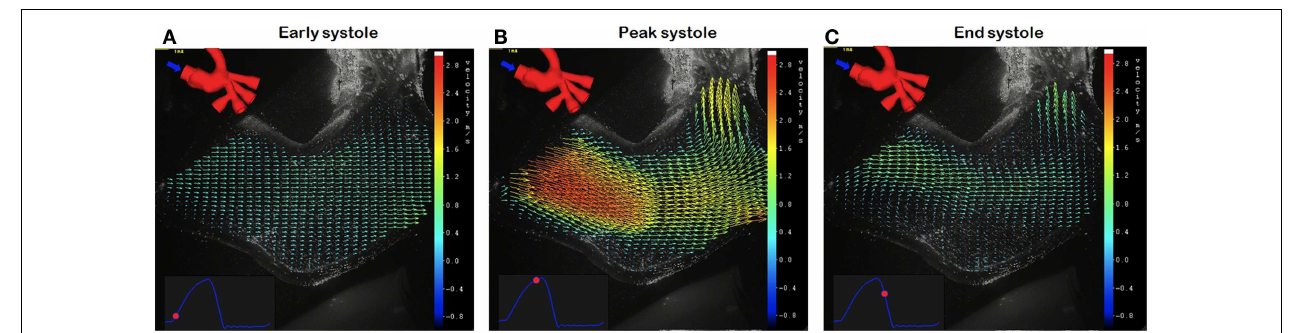
FIGURE 2 | Experimental set-ups for simulating the circulation following the Norwood operation, with modified Blalock-Taussig shunt (A) and Sano shunt (B) .The mock loops include a 3D patient-specific anatomical model.The Berlin Heart EXCOR simulates the single ventricle. C UB = lumped compliance for upper body district,